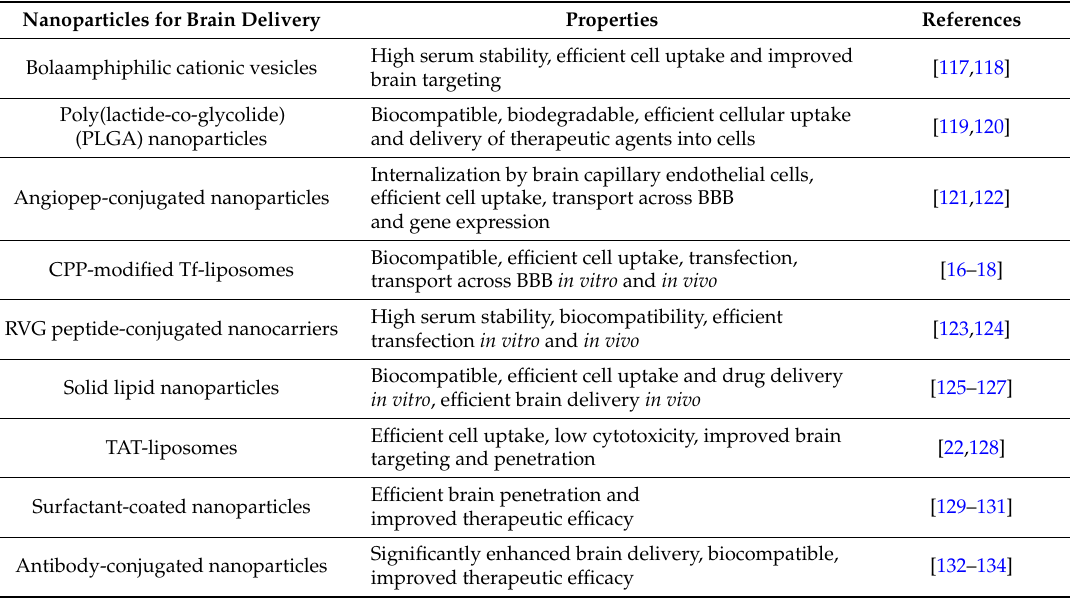
Table 2. Examples of drug and gene delivery vectors for transport across